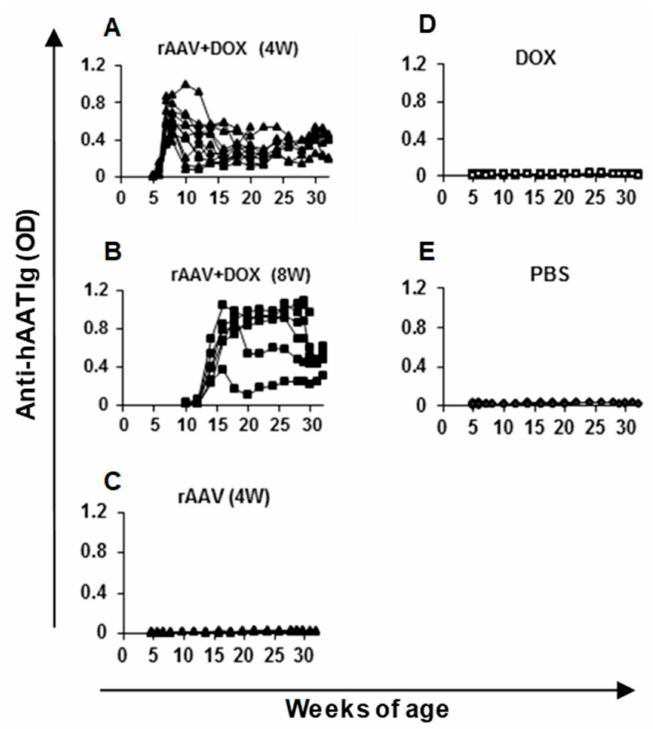
Figure 4. Anti-hAAT IgG levels in NOD mice. Serum samples from each mouse were diluted 100 times and subjected to ELISA. Each line represents data (optical density, OD) from an individual animal. The group labels are the same as indicated in Figure 3.